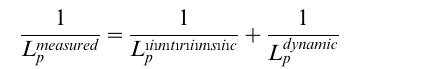
Figure S1 L p estimated from various sized samples of worm-like chains, showing overestimation when only a small number of chains are analyzed. 5000 3-dimensional worm-like chains with L c = 40 nm and L p = 44 nm were generated. Tangent angle correlation analysis of the whole population yielded L p = 44.7 nm (blue dashed line). From the whole population, a sample of N chains (N = 10, 20, 40 …) was randomly selected 200 times. L p was then estimated from tangent angle correlation for each sample; mean and standard error of the mean were finally calculated from the 200 repetitions. A consistent trend of overestimated L p , similar to that in the analysis of a Tm molecules (Figure 7), was observed for small N (i.e., , 80–160). The standard error of the mean, shown as vertical error bars, shows that the systematic overestimation is not due to the inherent variability of L p at small N. Figure S2 Asymmetric distribution of end-to-end lengths leading to under-sampling of highly bent configurations in small population of a Tm molecules. The normalized end-to-end length (l e-e ) distributions of various sized samples (black) from a total of 1852 a Tm molecules are overlaid on the distribution of all the molecules (grey). The number (N) of molecules in each sample increases from 10 to 400 (top to bottom; left to right). The same information is shown in expanded scales in the insets to highlight distributions of the subsets. For N , 100, most molecules in the samples were relatively straight, as evidenced by the long normalized l e-e (typically . 0.85); more bent configurations, or molecules with short l e-e , were under- or un-sampled. In contrast, l e-e distributions of samples with larger N ( . 100) contain more bent configurations and better resemble the l e-e distribution of all the